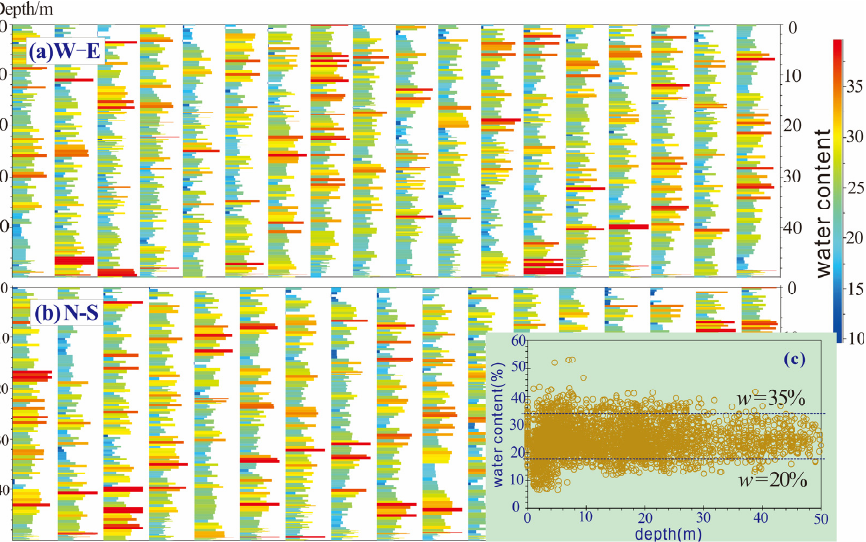
Figure 12. The water content of the subsoils ( a , b ) in the west–east (WE18) and north–south (NS12) orientations, respectively, derived from the 3D model; ( c ) all measured results vs. the depth.